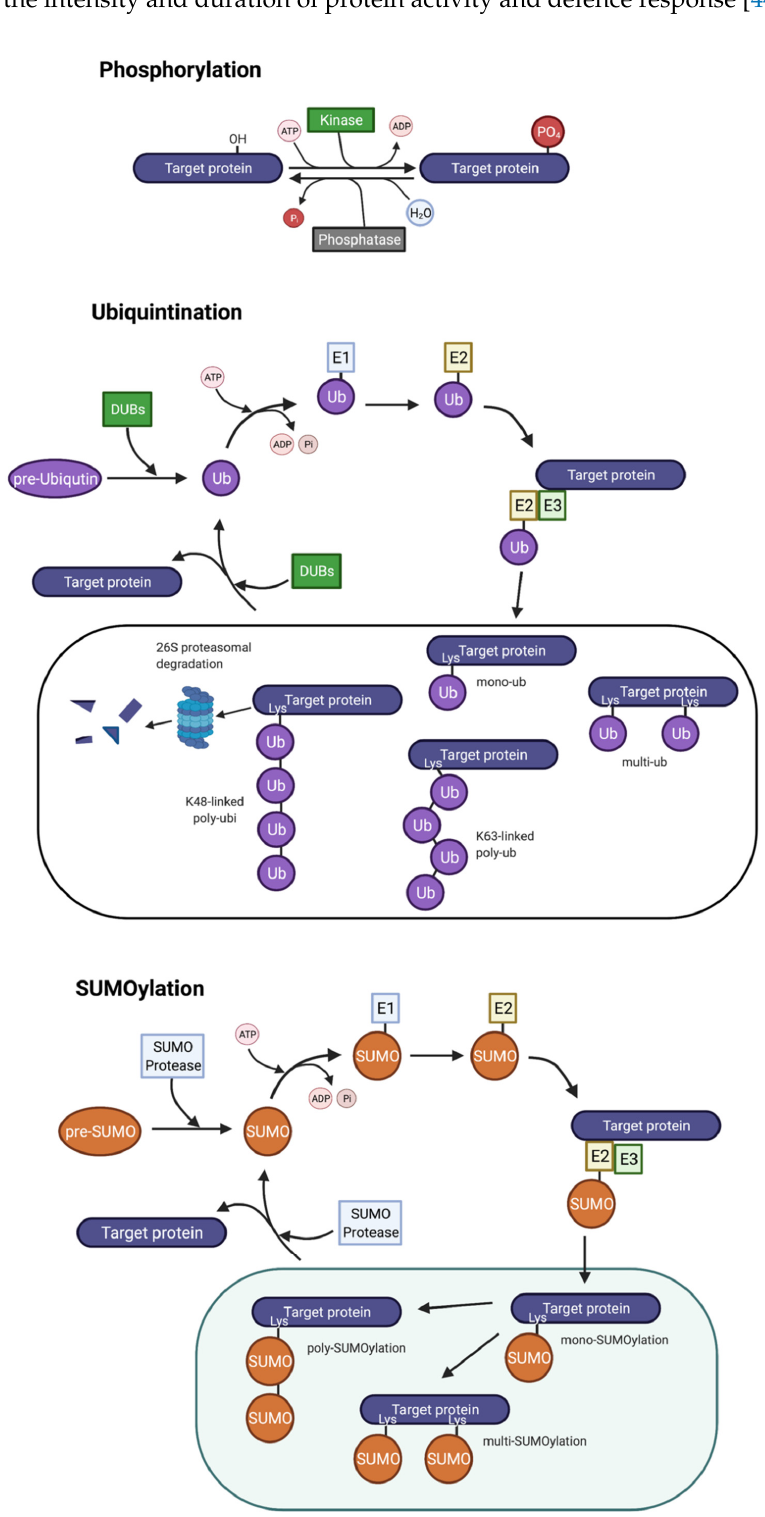
Figure 2. Post-translational modification pathways. Phosphorylation is the process catalysed by protein kinases in which a phosphate group (PO 4 ) is transferred from ATP onto the side-chain hydroxyl groups on serine, threonine, or tyrosine residues on a target protein. Phosphatases